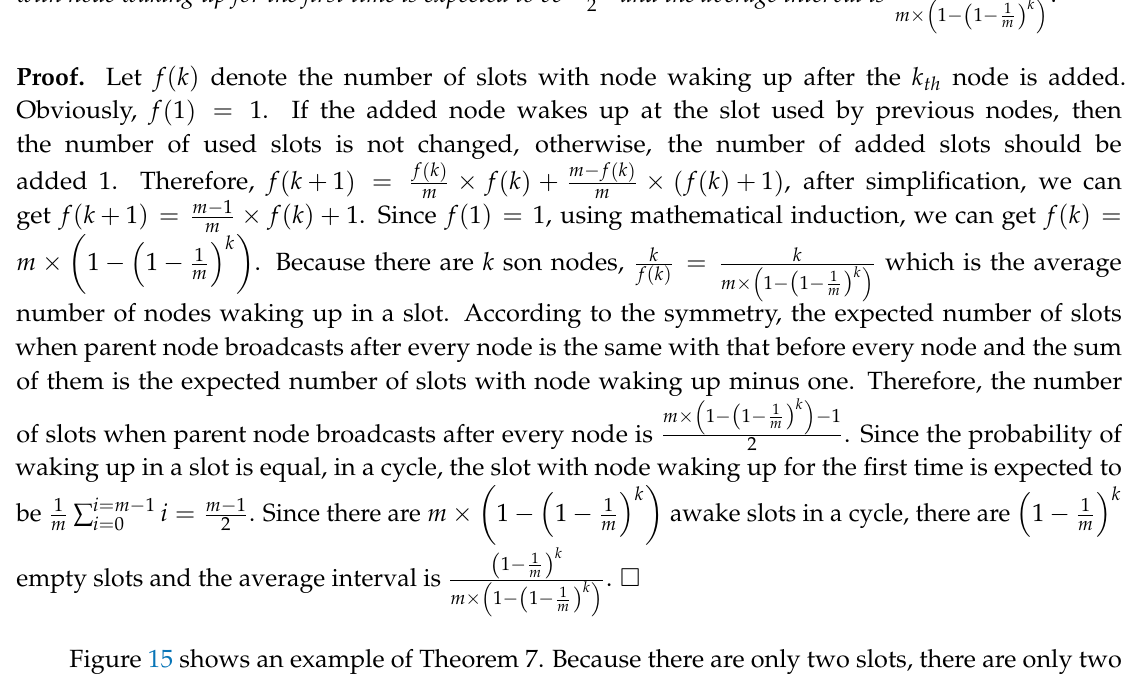
Figure 16. The influence trend of the number of nodes on slot coverage ( m = 20). Theorem 8. In traditional method, the expected delay is (cid:3040)(cid:2879)(cid:2869) (cid:2870) + ∑ ((cid:1842) (cid:3047)(cid:3045)(cid:3028)(cid:3041)(cid:3046) × (1 − (cid:1842) (cid:3047)(cid:3045)(cid:3028)(cid:3041)(cid:3046) ) (cid:3037)(cid:2879)(cid:2869) × ((cid:1862) − 1) × (cid:3037)(cid:2880)(cid:3021) (cid:3288)(cid:3276)(cid:3299) (cid:3037)(cid:2880)(cid:2869)